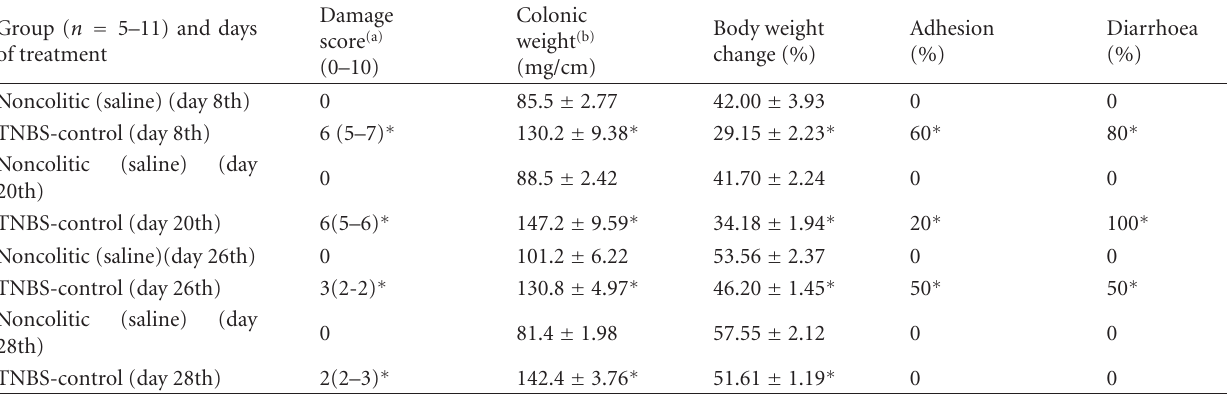
Table 3: Comparison between noncolitic and TNBS-control groups on damage score, colonic weight, body weight changes and incidence of adhesions and diarrhoea.